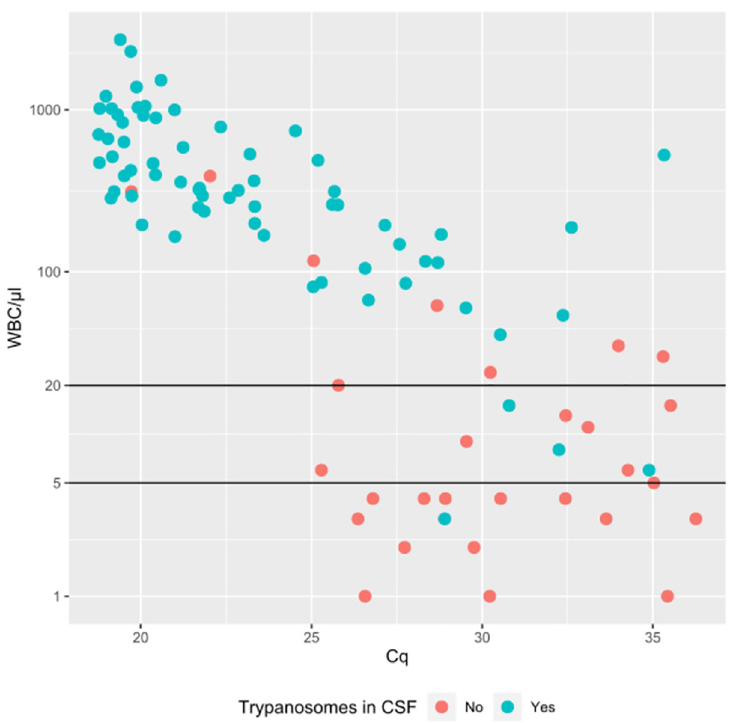
Fig 2. Cq values of the internal extraction control RT-qPCR in CSF in function of the CSF white blood cell count/ μ l. Blue dots: trypanosomes in CSF. Red dots: no trypanosomes in CSF.